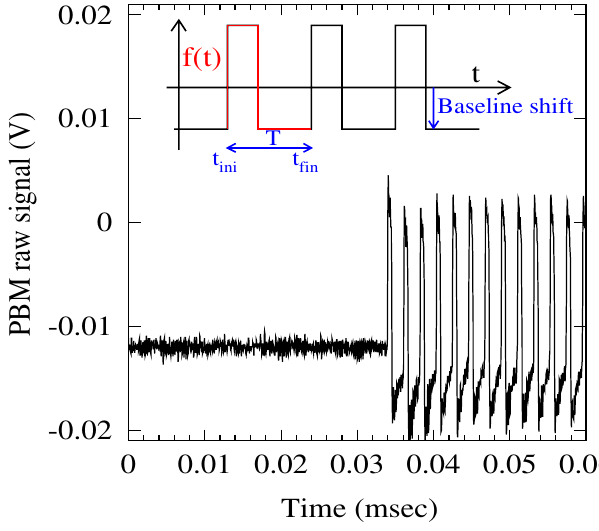
FIG. 4. (Color) Time domain signal from one of the four elec- trodes of BPM #21. The data is for the first several turns of the injection energy. The RCS was in beam storage mode with beam energy of 181 MeV, where only a single pulse with peak current of about 25 mA ( (cid:3) 1 (cid:1) 10 11 particles) from the linac was injected into RCS. The schematic drawing of the pulse function f ð t Þ with some notations given in the upper part was used in the derivations presented in this